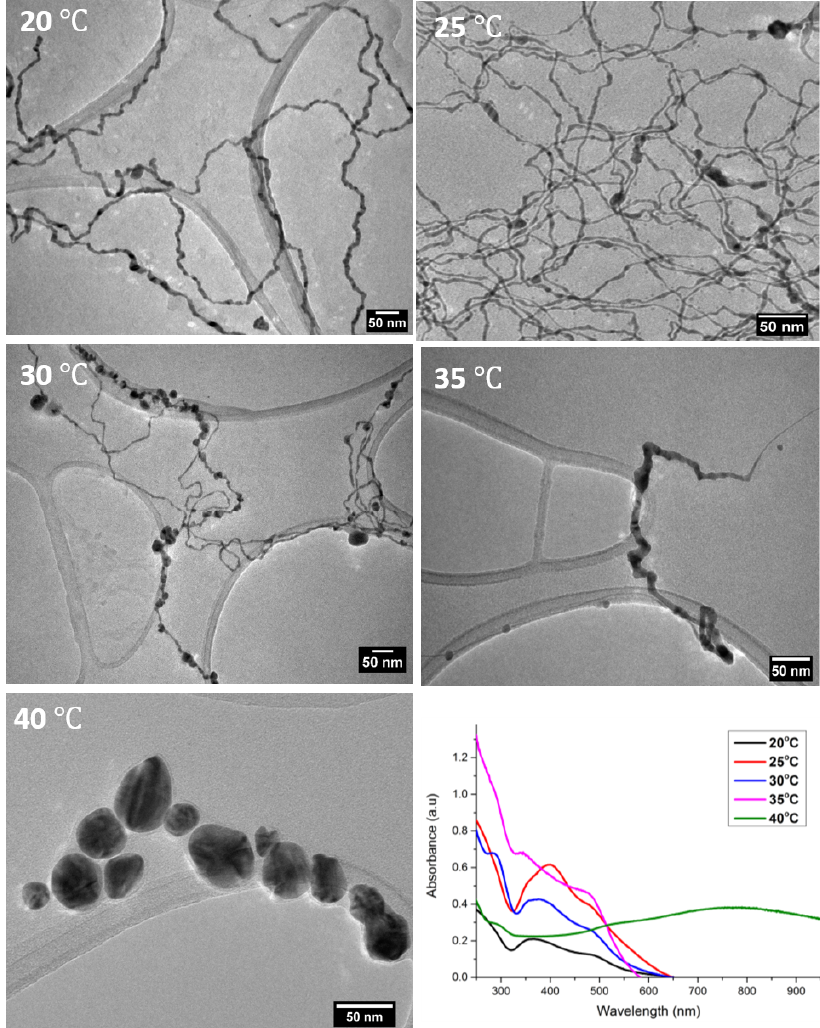
Figure 1. TEM and UV-Vis analysis of products following dilution after aging at various temperatures for 18 h.